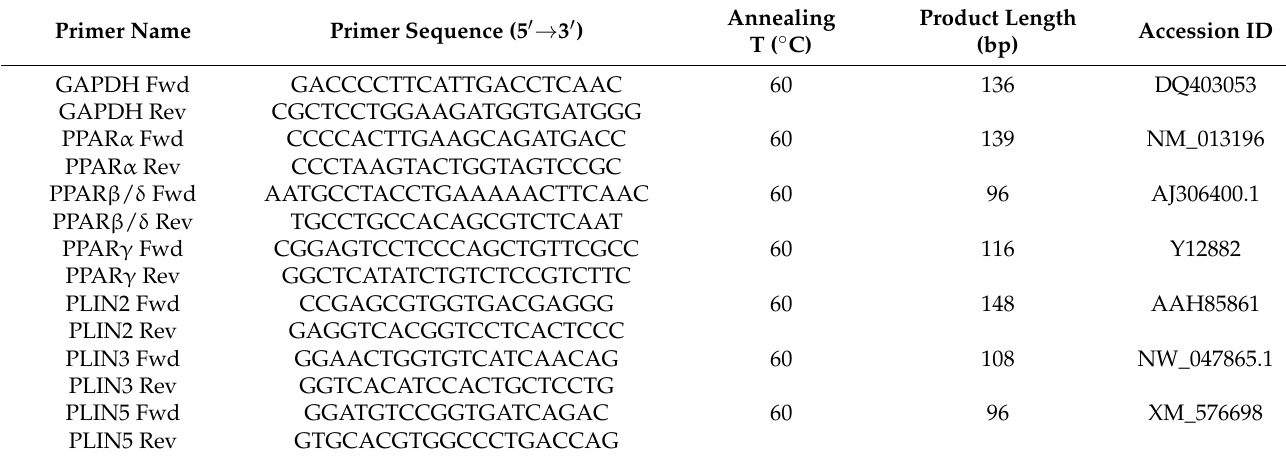
Table 1. Primer pairs used for RT-qPCR